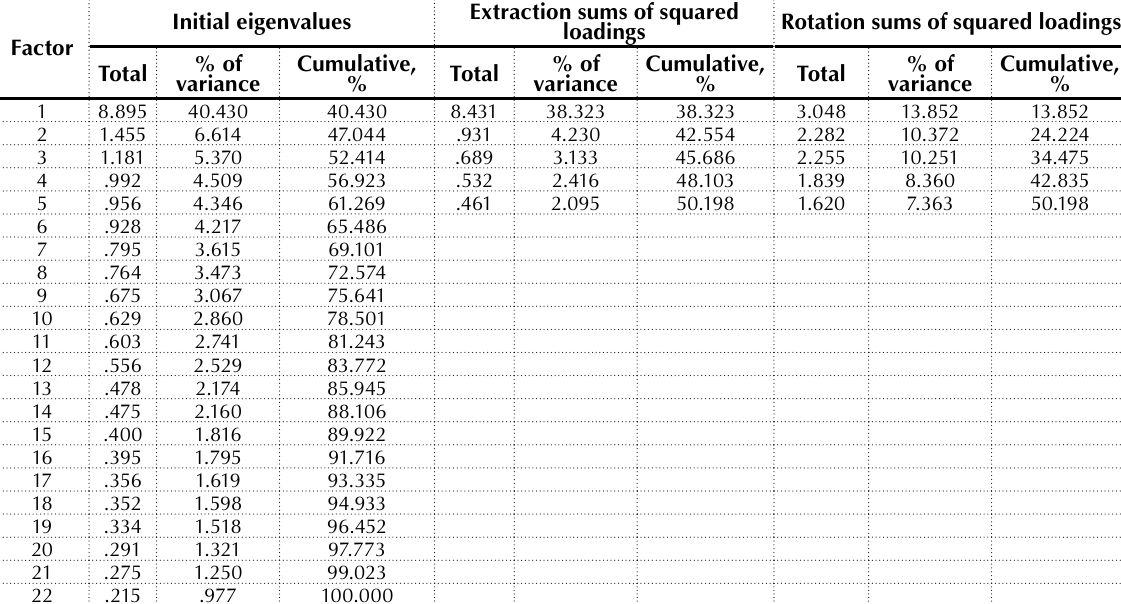
Extraction sums of squared Rotation sums of squared loadings